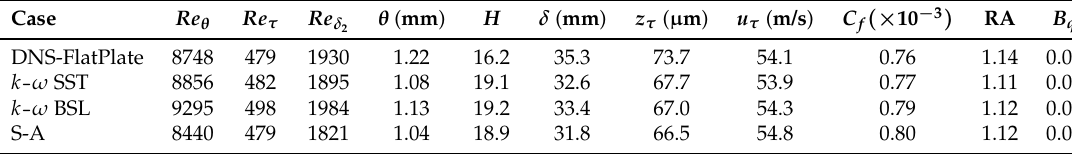
Table 2. Comparison of boundary-layer parameters between RANS and